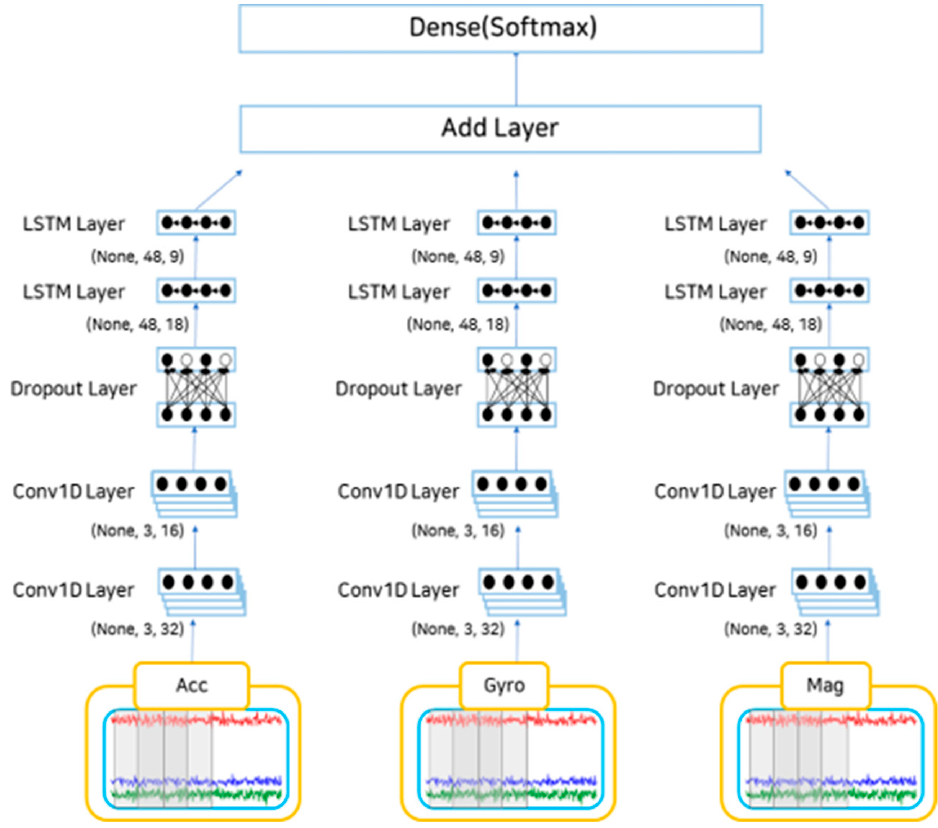
Figure 4. CNN-LSTM hybrid model of the behavioral prediction model structure. Figure 4. CNN‑LSTM hybrid model of the behavioral prediction model